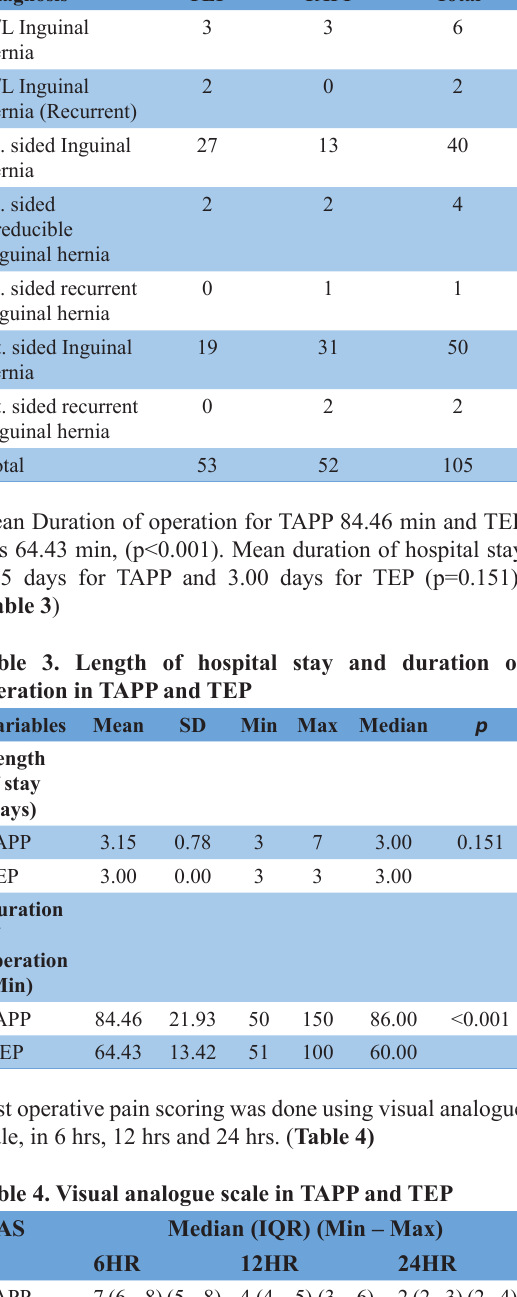
Table 2. Types of Hernia Diagnosis